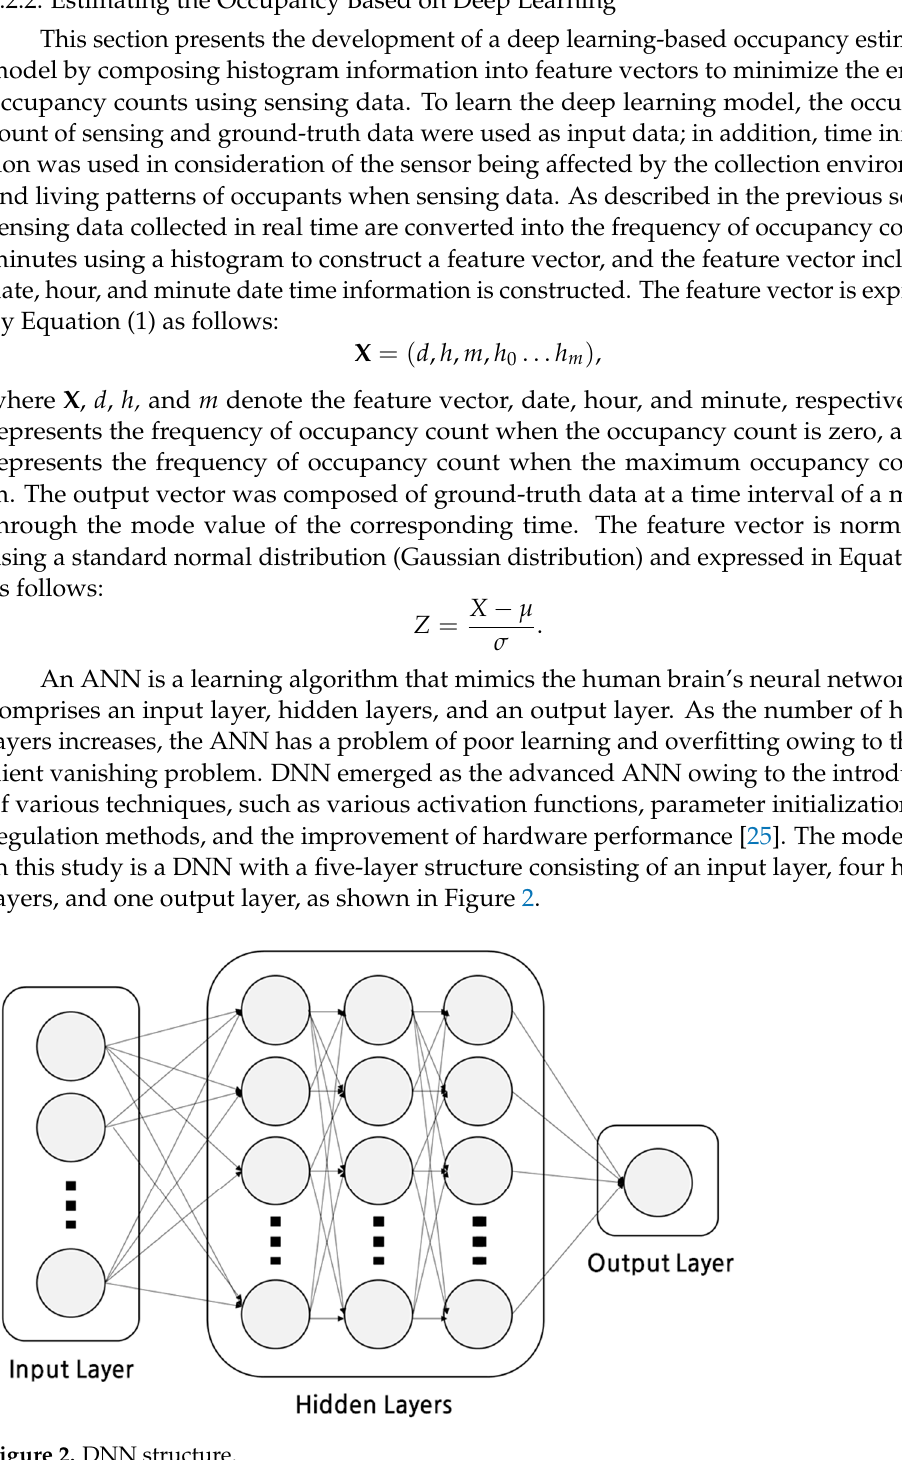
Figure 2. DNN Figure 2. DNN structure.